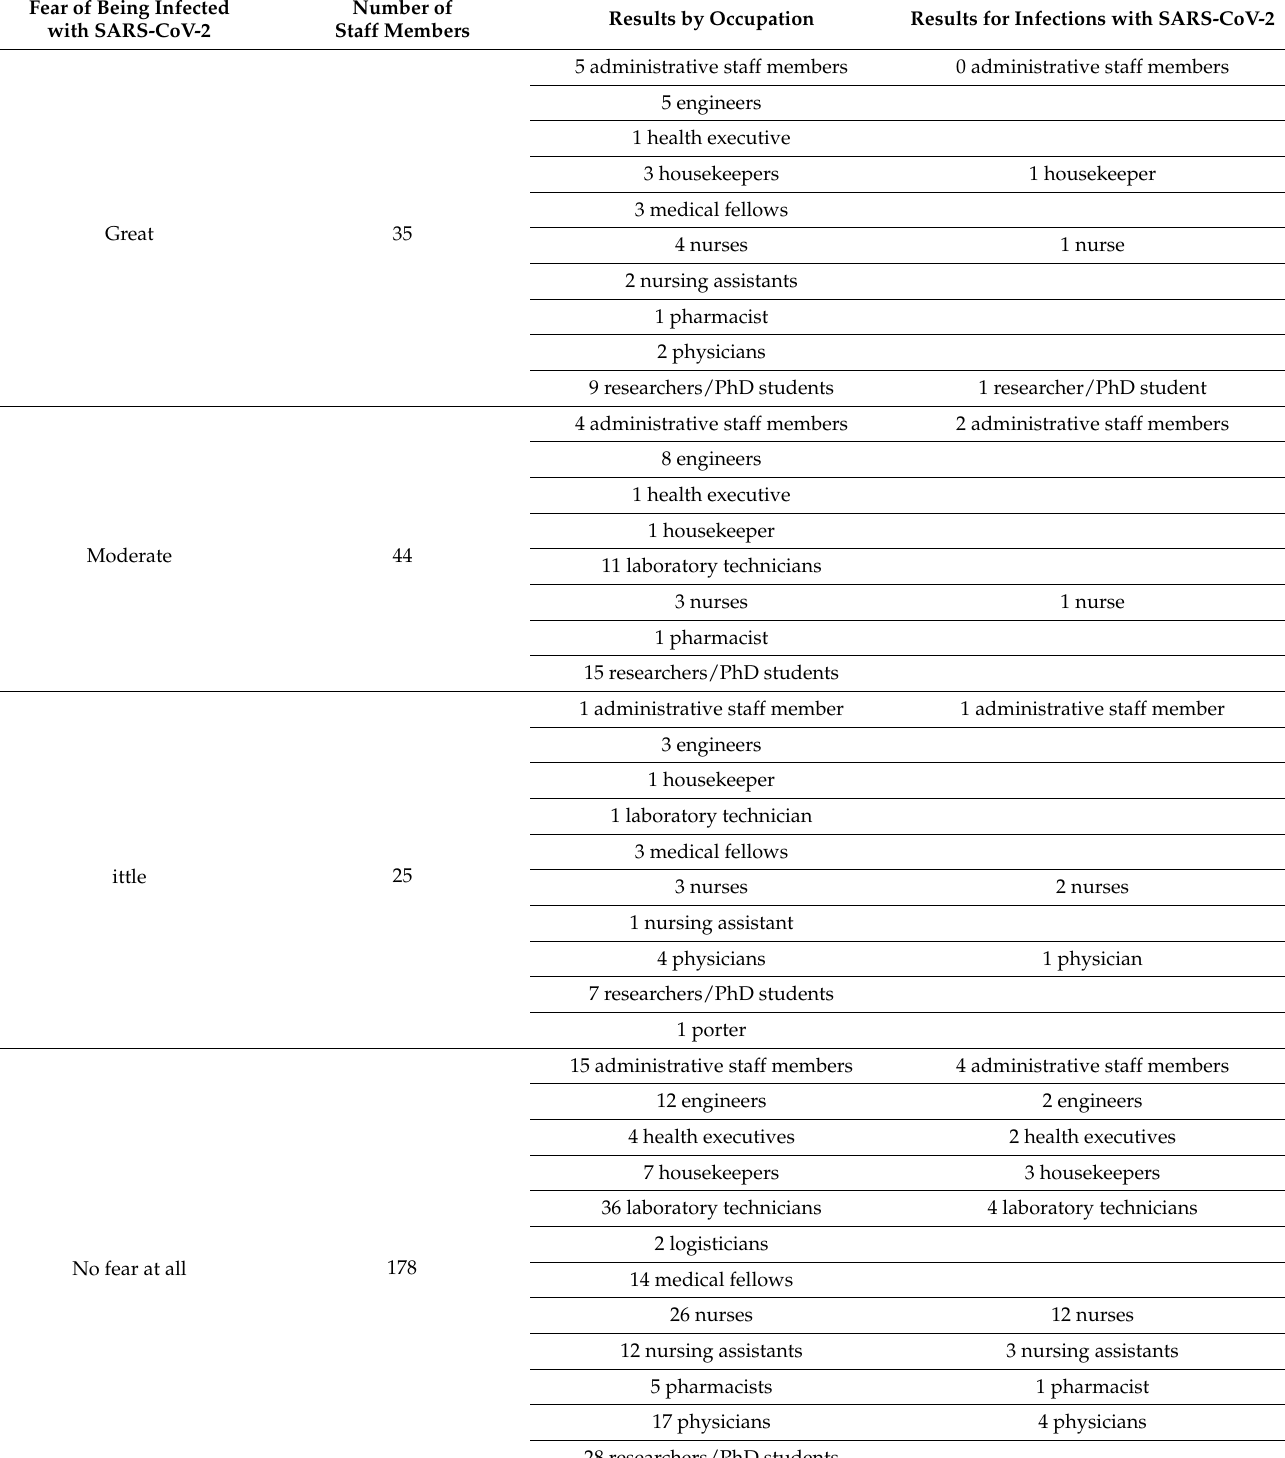
Table 2. Screening of 286 IHU staff members on their fear of being infected with SARS-CoV-2. Fear of Being Infected Number of with SARS-CoV-2 Staff Members